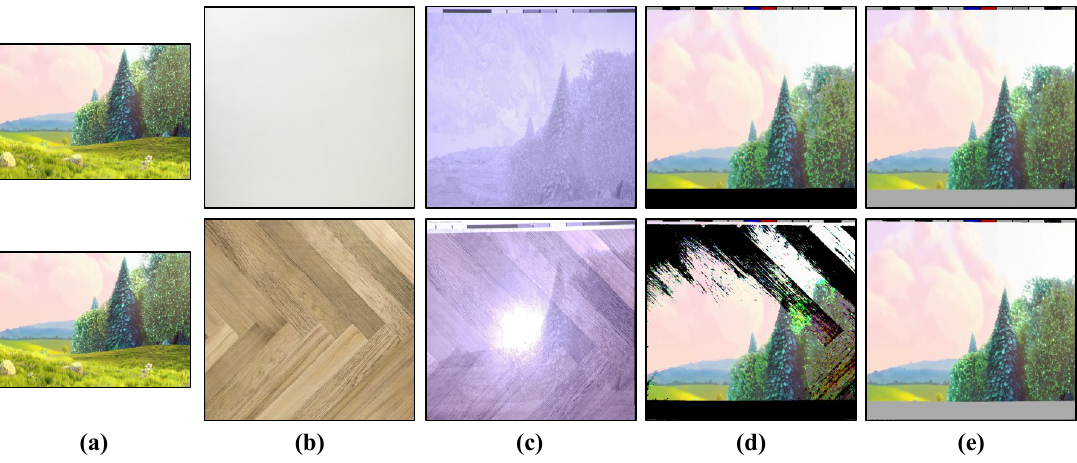
Figure 8. ( a ) original image; ( b ) background pattern; ( c ) projection on a background pattern; ( d ) reconstructed image without background subtraction; and ( e ) reconstructed image with background